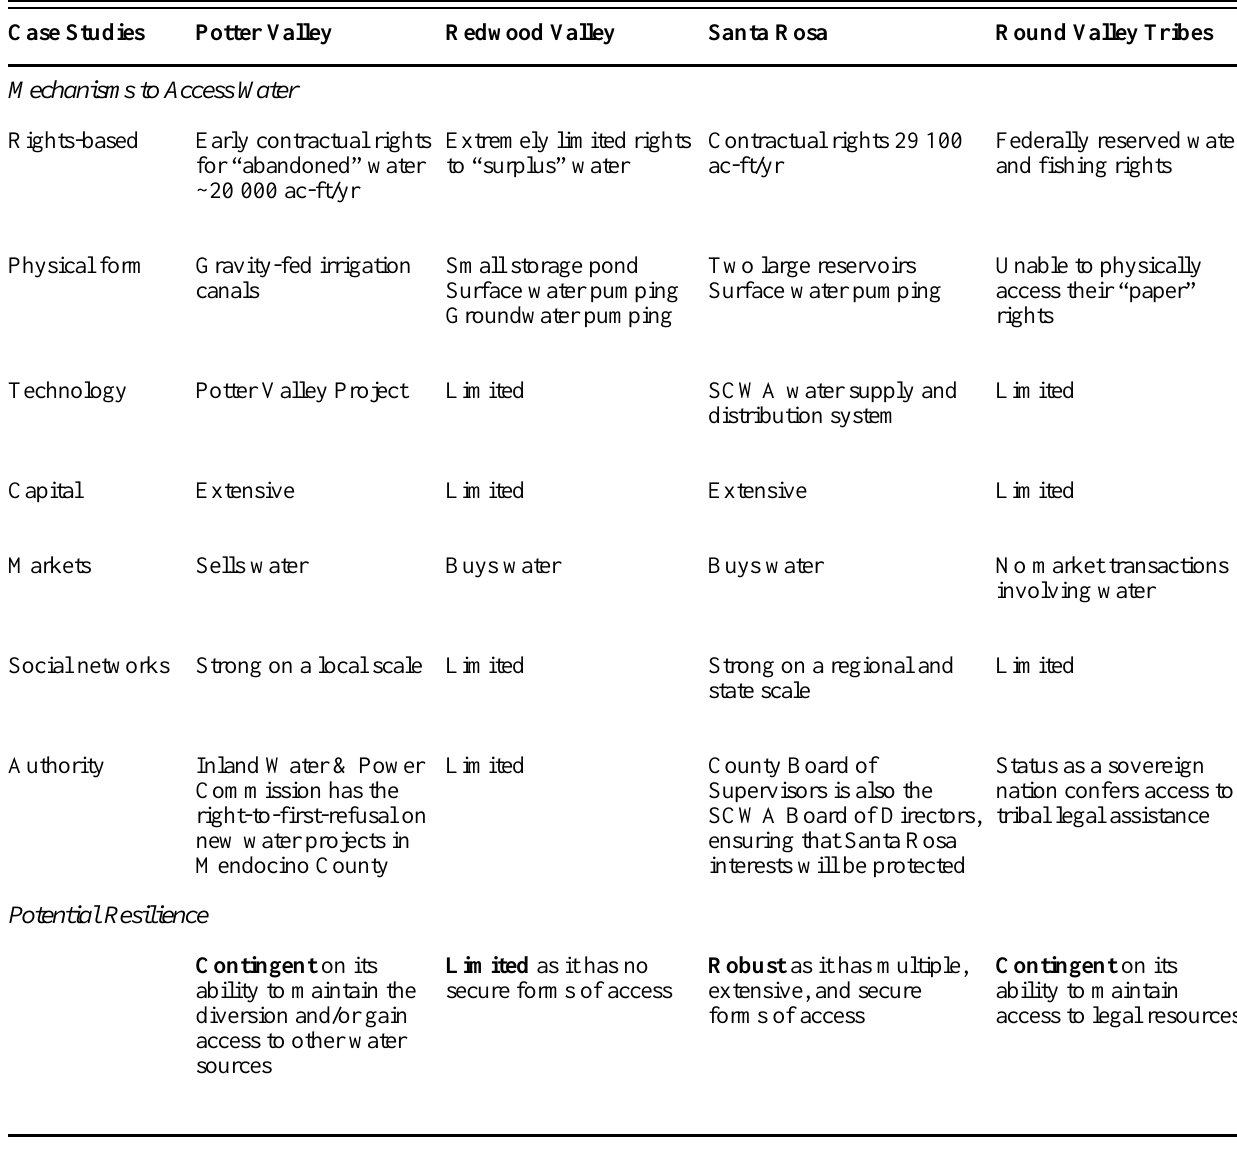
Table 2. Access and